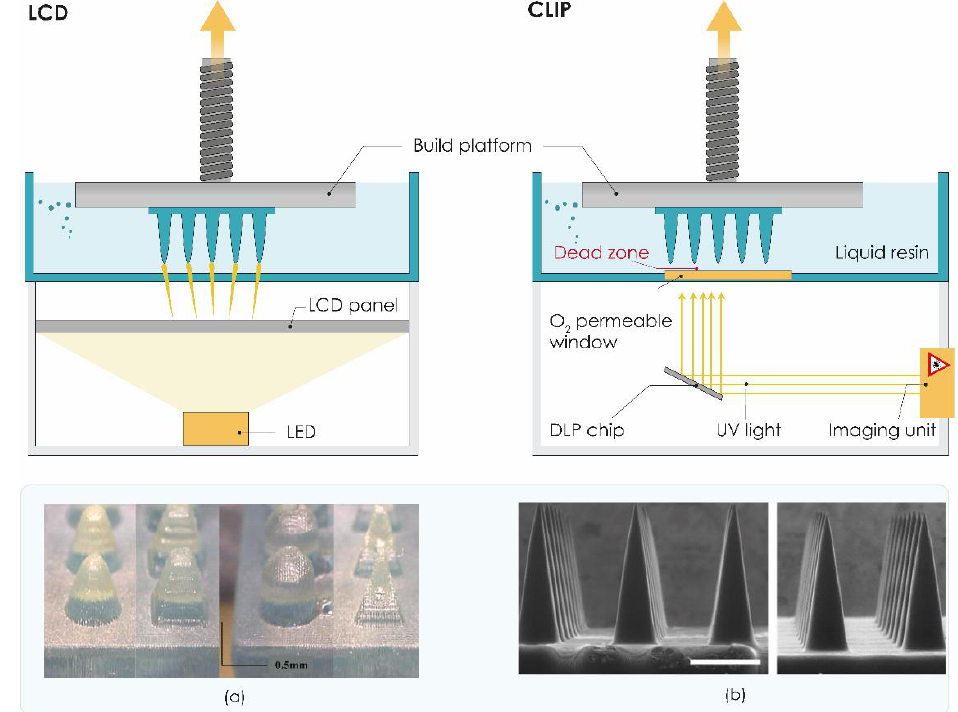
Figure 4. The working principle of liquid crystal display (LCD) and continuous liquid interface production (CLIP). ( a ) Microneedles produced by LCD. Reproduced with permission from [138], Elsevier, 2021 and ( b ) CLIP technology. Reproduced with permission from [139], PLOS, 2016. The image was created with Adobe Illustrator CC (Version 23.0.1.; Adobe Inc., San Jose, CA, USA, 2019).